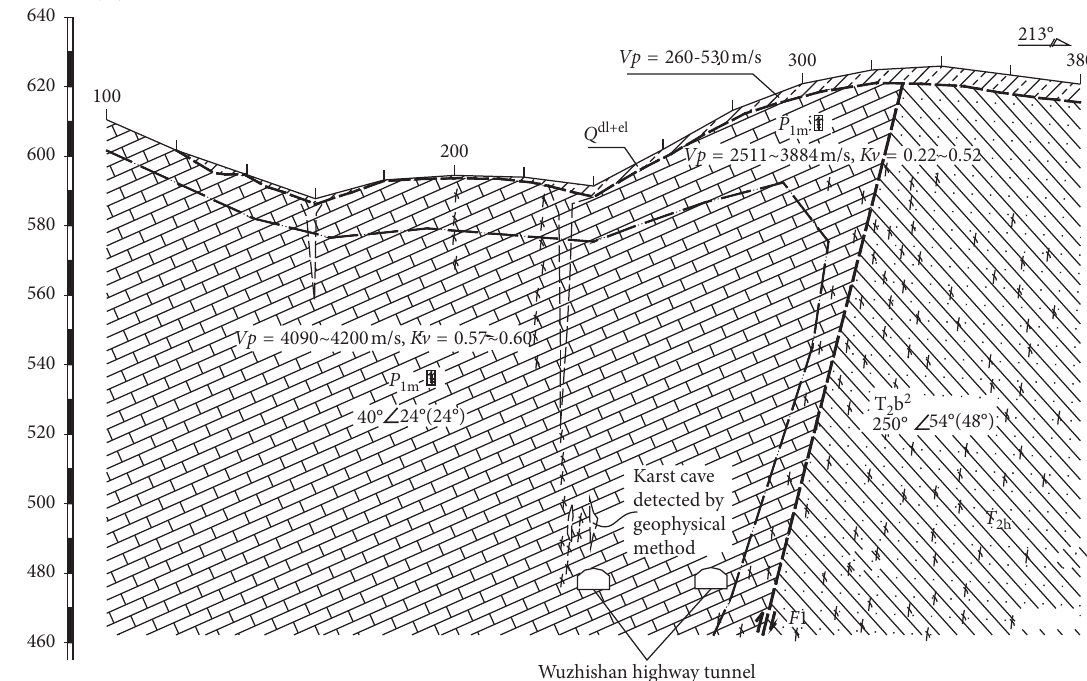
Figure 10: Engineering geological conditions for a certain cross section of the Wuzhishan Table 1: The parameters of rock mass provided by geological survey report of Wuzhishan tunnel. A B μ